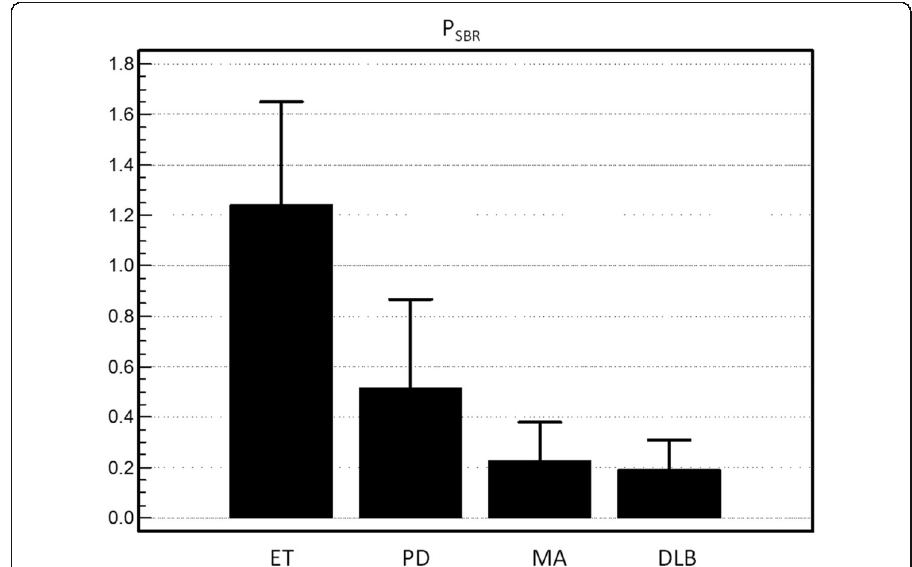
Fig. 3 Putamen specific binding ratios. Putamen specific binding ratio (P SBR ) plotted for patients with essential tremor (ET), Parkinson ’ s disease (PD), multiple system atrophy (MA) and dementia with Lewy bodies (DLB)